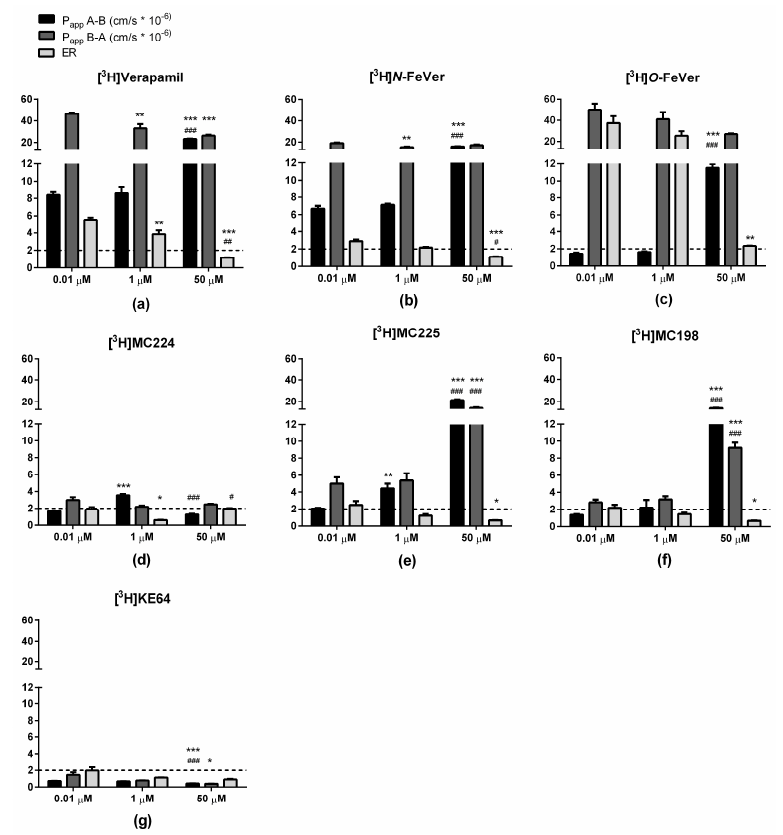
Figure 2. Bidirectional transport ( P app and ER) of ( a ) [ 3 H]verapamil, ( b ) [ 3 H] N -FeVer, ( c ) [ 3 H] O -FeVer, ( d ) [ 3 H]MC224, ( e ) [ 3 H]MC225, ( f ) [ 3 H]MC198 and ( g ) [ 3 H]KE64 in MDCKII-MDR1 cells (mean ± SEM) tested at different concentrations: 0.01 µM ( n = 6), 1 µM ( n = 3) and 50 µM ( n = 3). * Symbol represents a significant difference with 0.01 µM (* p < 0.05, ** p < 0.01, *** p < 0.001) and # symbol a significant difference with 1 µM (# p < 0.05, ## p < 0.01, ### p < 0.001).